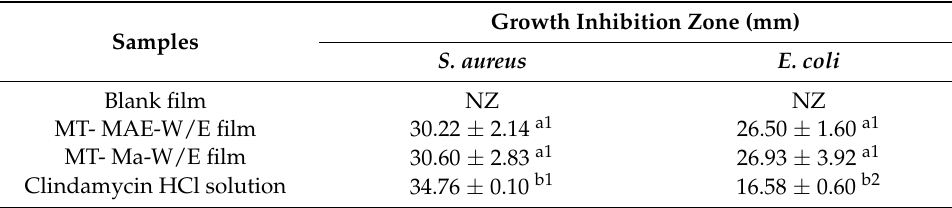
The experiment was performed in triplicate. Mean ± S.D. values in the same column with different letters ( a,b ) indicate a significant difference ( p < 0.05). Values in the same row with different numbers ( 1,2 ) indicate a significant difference ( p < 0.05). NZ indicates no growth inhibition zone